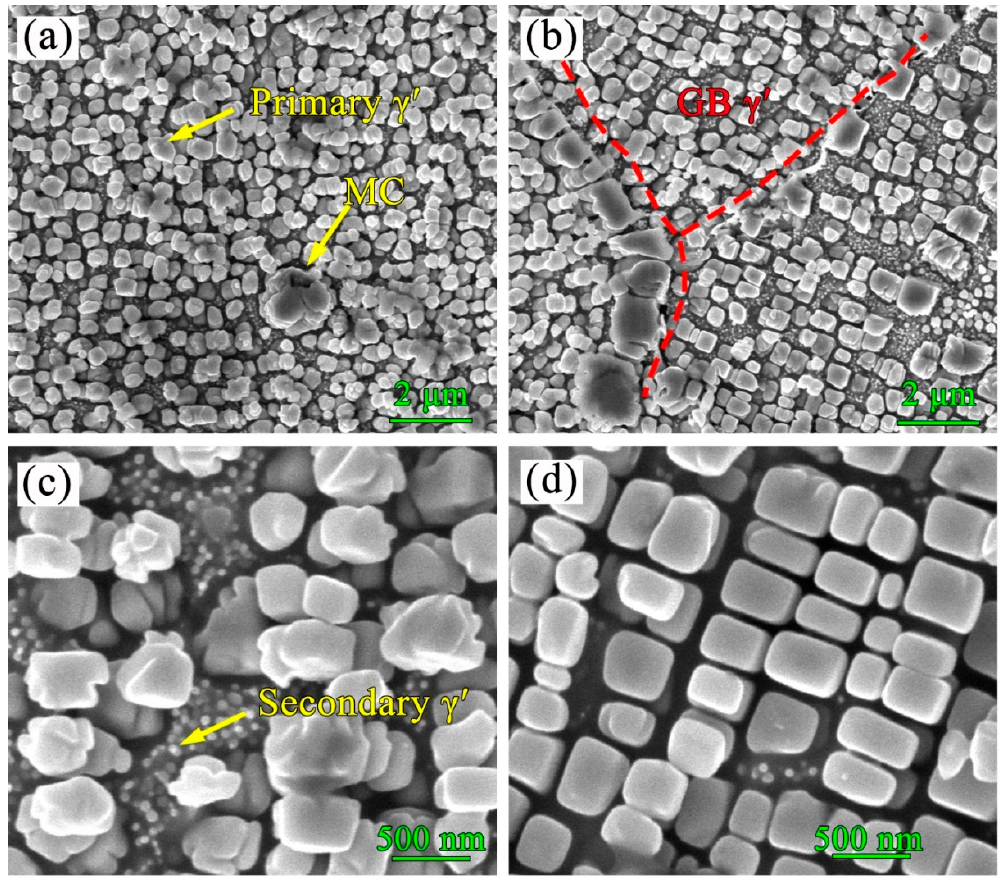
Figure 11. The precipitates in HT sample, ( a ) bimodal γ′ particles and block MC carbides, ( b ) grain boundary γ′ phases, ( c ) spherical γ′ particles, and ( d ) cuboidal γ′ particles.